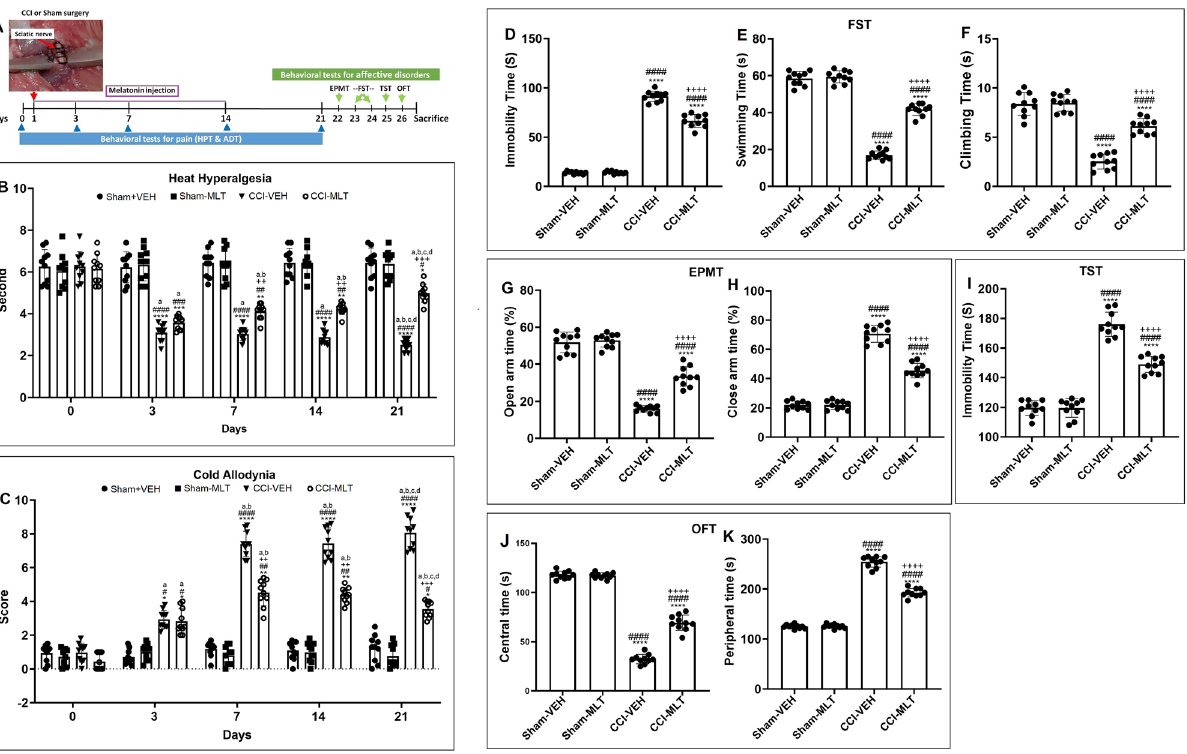
Figure 1. ( A ) Study protocol. Effects of melatonin (MLT) on the pain and flowing mood problems in the rat model of chronic constriction injury (CCI). ( B ) Heat hyperalgesia and ( C ) Cold allodynia for the assessment of pain on days 0, 3, 14, and 21, ( D–F ) forced swimming test, ( G,H ) elevated plus maze test, ( I ) tail suspension test, and ( J,K ) open field test. * P < 0.05, ** P < 0.01, *** P < 0.001, and **** P < 0.0001 compared with the Sham-VEH group; # P < 0.05, ## P < 0.01 . ### P < 0.001, and #### P < 0.0001 compared with the Sham-MLT group, + P < 0.05, ++ P < 0.01, +++ P < 0.001, and ++++ P < 0.0001 compared with the CCI-VEH group. a P < 0.05 compared with the same group on day 3, b P < 0.05 compared with the same group on day 7, c P < 0.05 compared with the same group on day 14, d P < 0.05 compared with the same group on day 21. Sham-VEH: